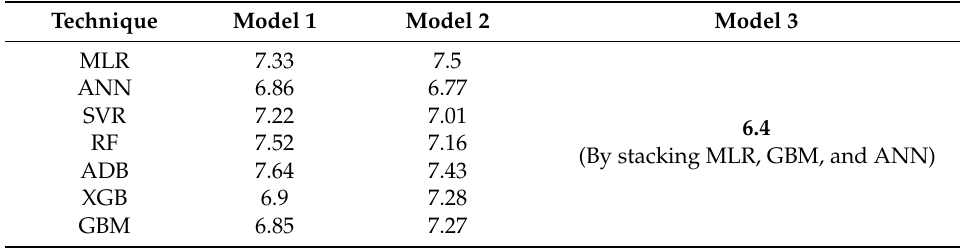
Table 2. Resulting MAPE of Model 1, Model 2, and Model 3 for various machine learning techniques.